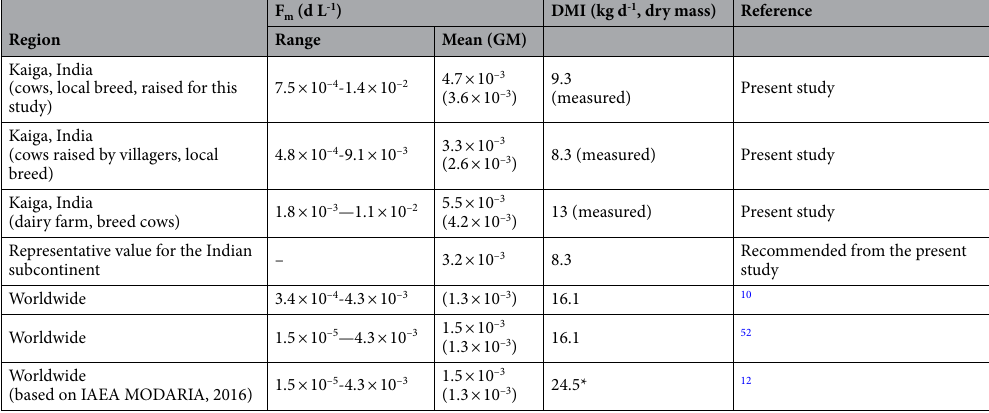
Table 6. Comparison of the F m values for Sr. * Corresponding to the animal of live-weight of 700